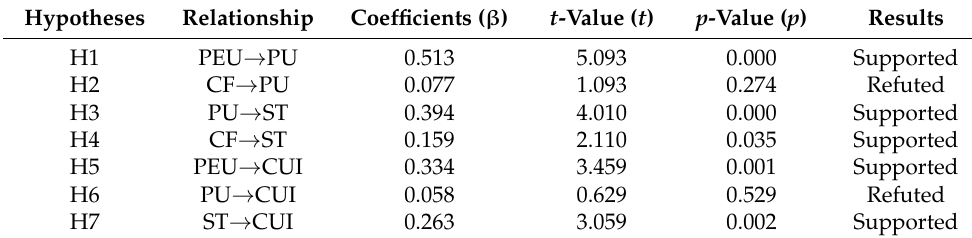
Table 6. Results of the hypothesis tests.